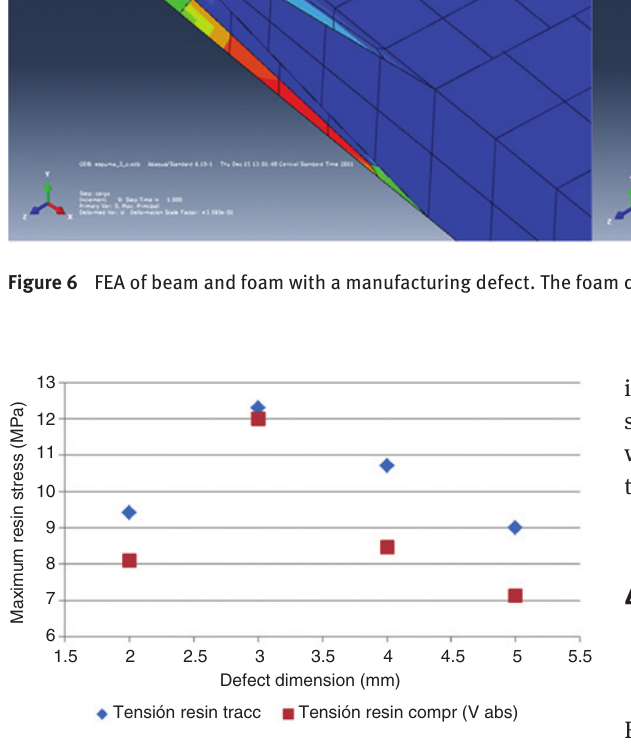
Figure 7 Influence of defect dimension on maximum stress (in absolute value).